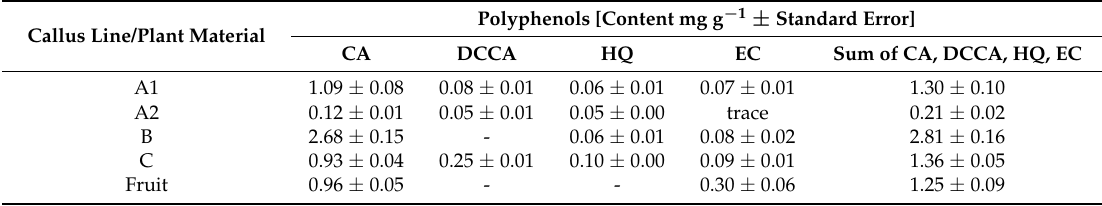
Table 2. The content (mg g − 1 d.w .) of selected polyphenols in four lines of Chaenomeles japonica callus. Callus Line/Plant Material